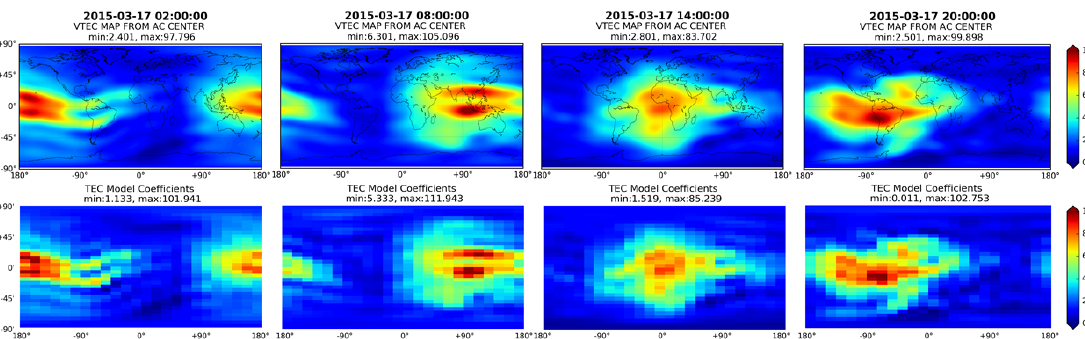
Figure 1. The panels in the top row show the VTEC maps from IGS final GIMs drawn in an Earth-fixed coordinate system at 02:00, 08:00, 14:00 and 20:00 UTC for 17 March 2015. The corresponding maps of estimated B-spline coefficients for each of the VTEC maps are illustrated in the bottom row; the B-spline ( t ) refer to resolution levels; J = 5 and J = 3 for latitude and longitude, coefficients d J 1 , J 2 2 1 k k 1 , k 2